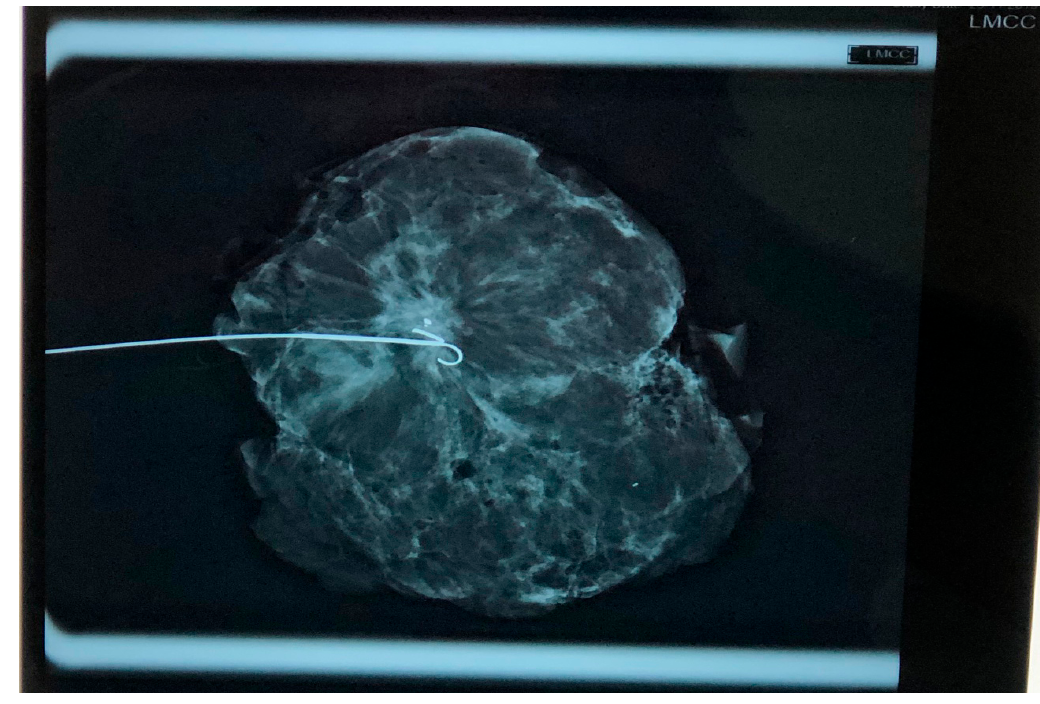
Figure 3. Specimen mammogram.